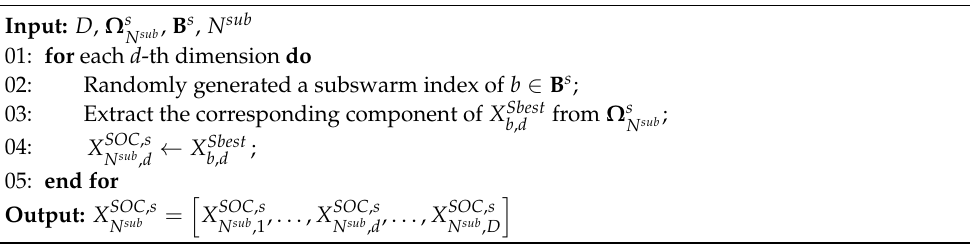
Algorithm 4. Social Exemplar Scheme for the Best Particle in Each